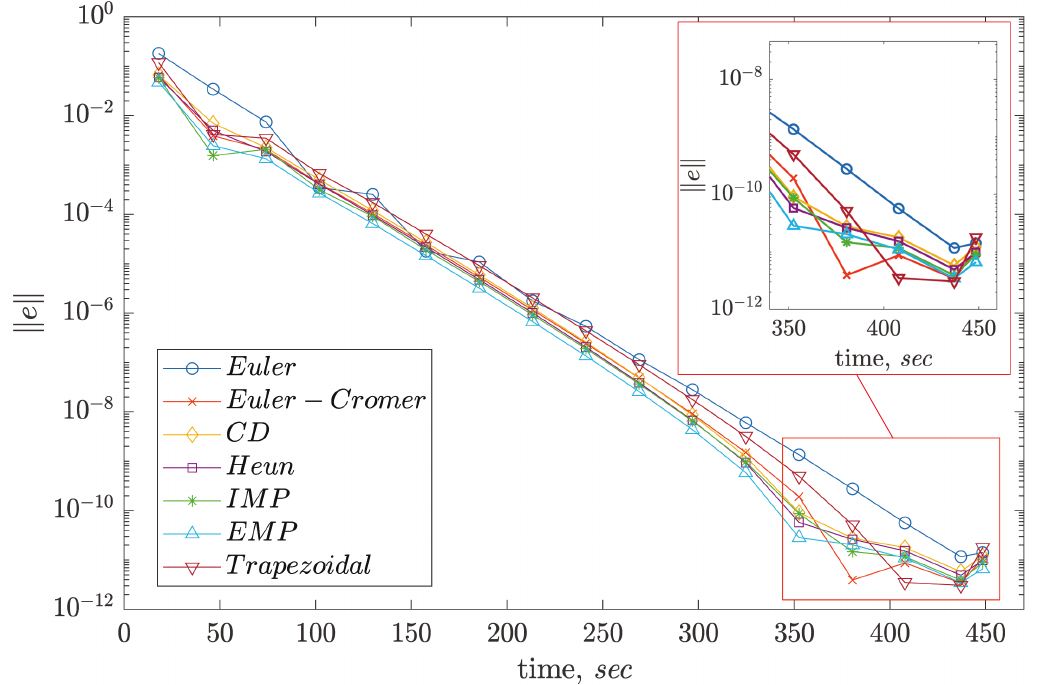
Figure 11. Synchronization error between slave systems for different integration methods, smoothed with a median filter; the window size is 200